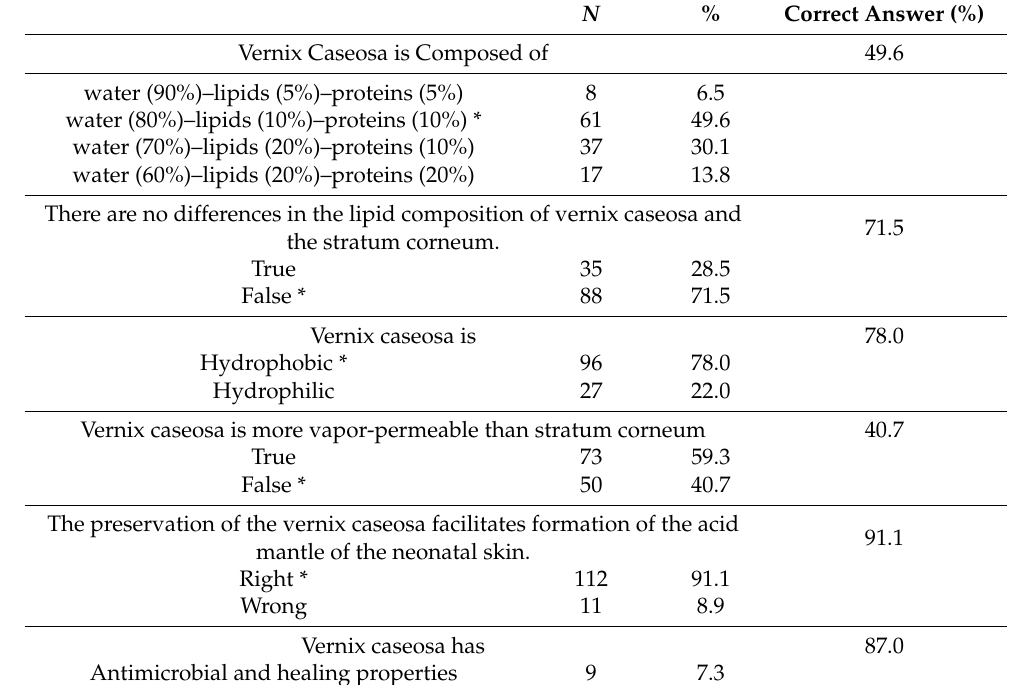
Table 2. Questions and healthcare professionals’ performance regarding theoretical knowledge about neonatal vernix caseosa, skin microbiota and